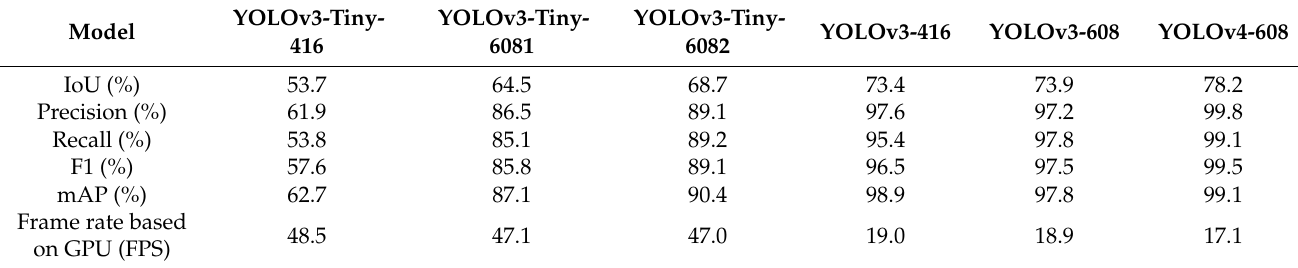
Table 1. Results of the network test